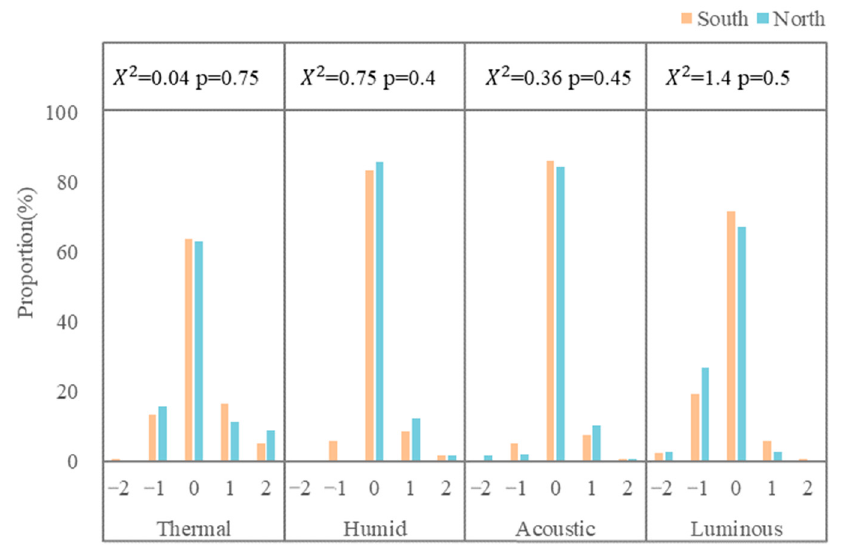
Figure 13. Environmental sensation vote of different room orientations and the chi-square test results.